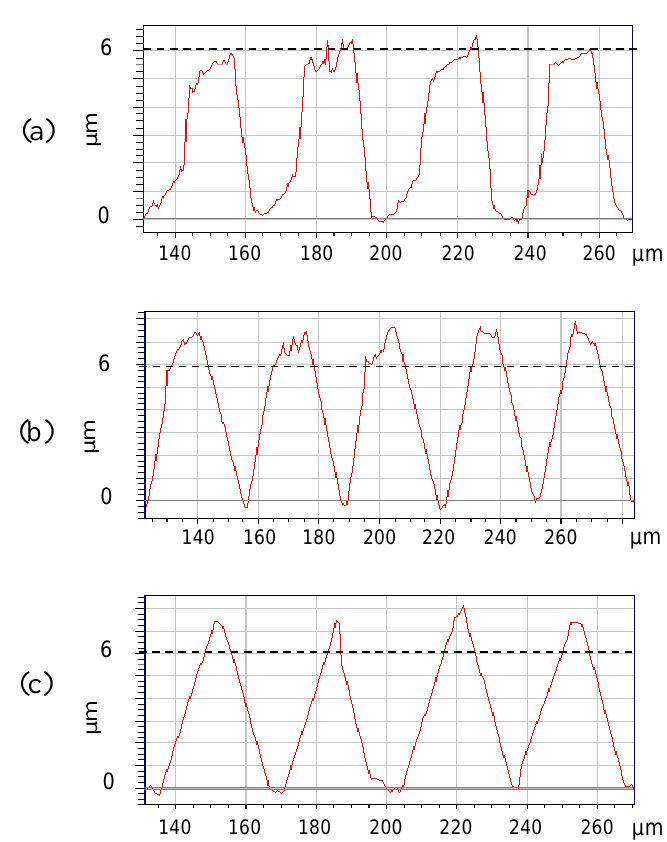
Figure 8. Veeco Dektak Stylus Profilometry 2D for LDPE films imprinted with ( a ) no heat; ( b ) 1.2 kW and ( c ) 1.6